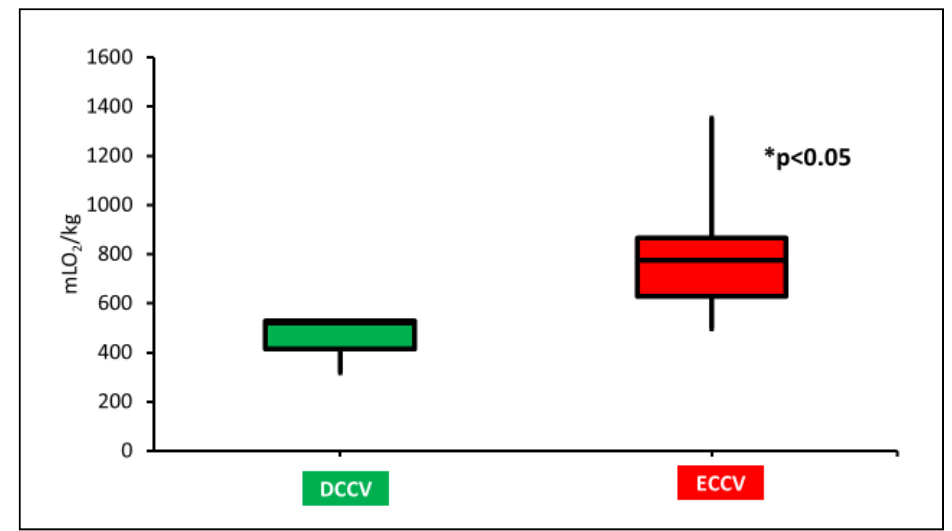
Figure 3. The oxygen load (OL) in milliliters of oxygen per kilogram is shown on the y-axis. The box and whiskers plot shows a significantly higher OL with ECCV compared to DCCV. OL in ECCV was significantly higher compared to DCCV (* p < 0.05 by Kruskal-Wallis test). ECCV, the PaO 2 was significantly higher (95 ± 65 mmHg) compared to DCCV (38 ± 9